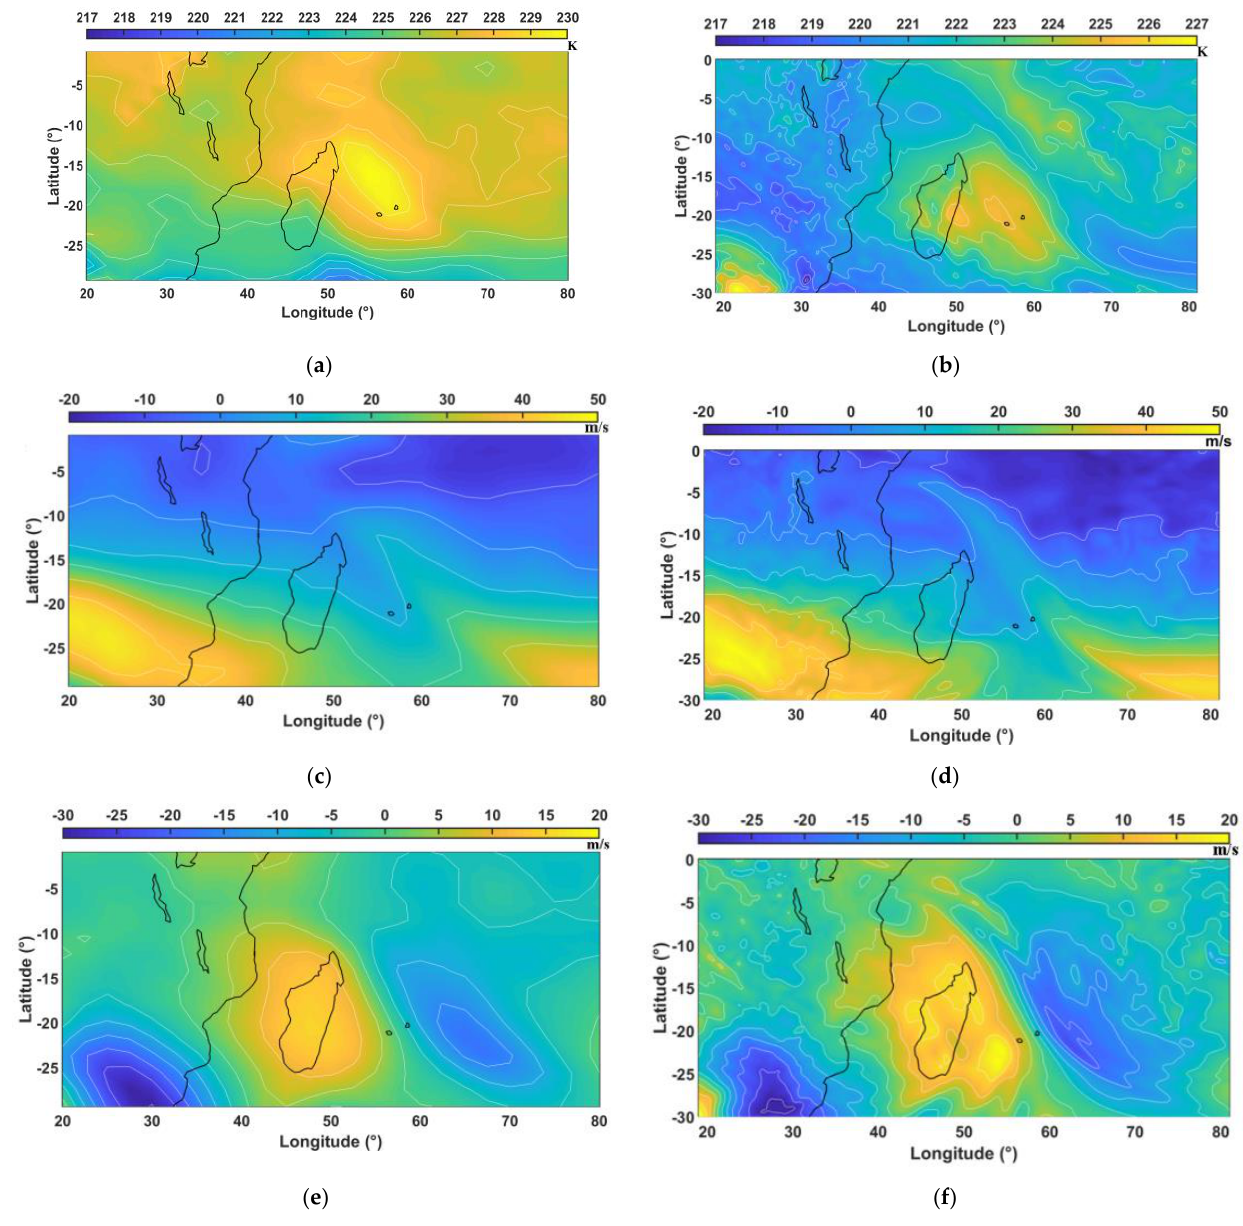
Figure 2. Temperature (K), zonal (m/s), meridional wind (m/s) on 9 October 2017 at ≈ 10.5 km height derived from WACCM ( a , c , e ), respectively, at 1200 UTC and from ERA5 with 137 levels ( b , d , f ) at 1100 UTC.